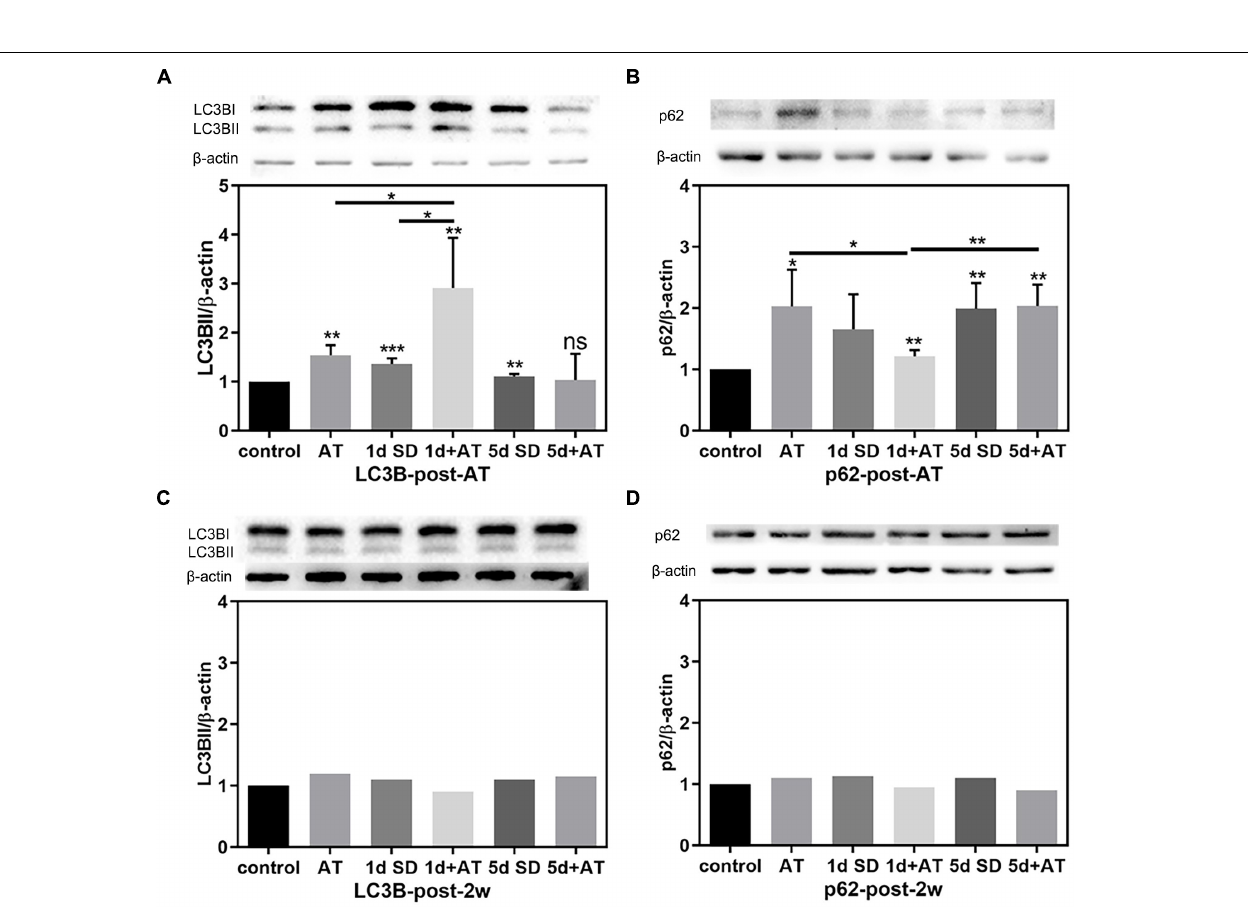
FIGURE 5 | The changes in autophagy protein expression in cochleae after SD and AT procedures. (A) The western-blotting analysis of LC3B expression in all six groups, showing the ratios of LC3BII to β -actin after acoustic trauma (post-AT) ( n = 4). (B) The western-blotting analysis of p62 expression in all six groups, showing the ratios of p62 to β -actin at the time point of post-AT ( n = 4). (C) The western-blotting analysis of LC3B expression at post-2w ( n = 1). (D) The western-blotting analysis of P62 expression at post-2w ( n = 1). The data are shown as the mean ± SD. Two-tailed, unpaired Student’s t -tests were used to determine statistical